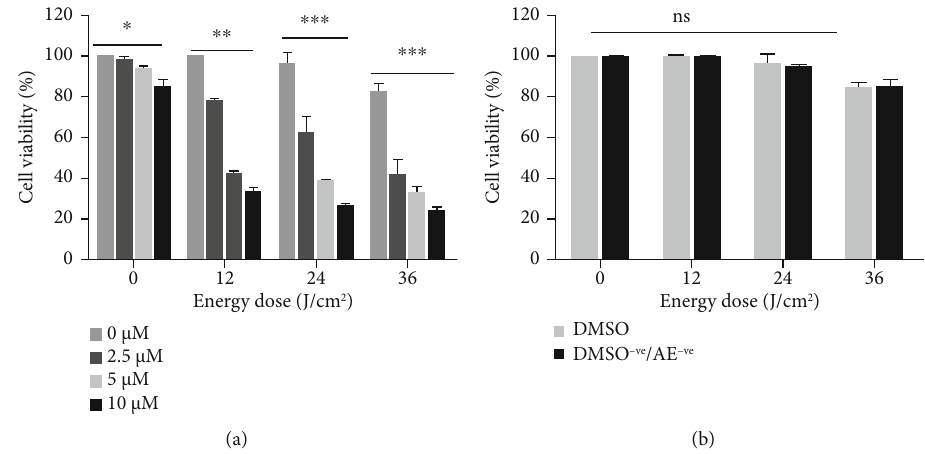
Figure 2: The viability of TE 354.T cells after AE-mediated PDT treatment. (a) Percentage of TE 354.T cell viability after treatment with varied AE concentrations and light energy doses. The photosensitizer at concentrations of 0, 2.5, 5, and 10 μ M were introduced into the adhered cells for 4 hours and later irradiated with 0, 12, 24, and 36J/cm 2 . Cell viability was analysed 12 h postirradiation by CCK-8 kit ( ∗ p < 0 : 05 , ∗∗ p < 0 : 01 , and ∗∗∗ p < 0 : 001 ); (b) viability of ATCC TE 354.T cell in the control group. The cells were incubated for 4 hours with either DMSO or without any treatment. The cells were exposed to irradiation with an energy dosage of 0, 12, 24, or 36 J/cm 2 . No signi fi cant di ff erence was reported between the two control groups at any given dosage of energy ( p > 0 : 05 ).